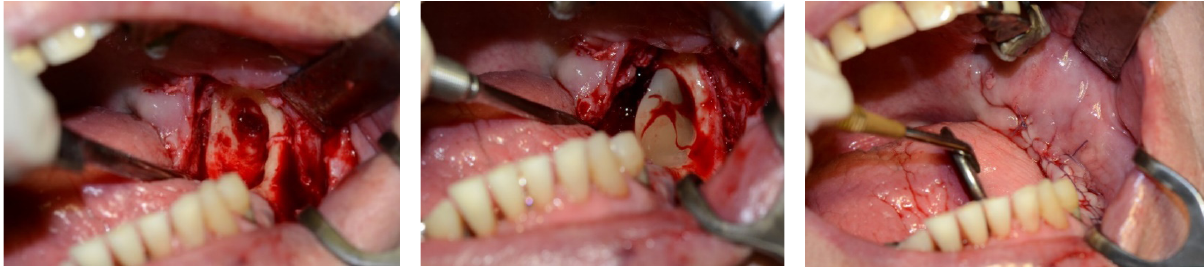
Fig. 1. Operation site after resection of necrotic bone.